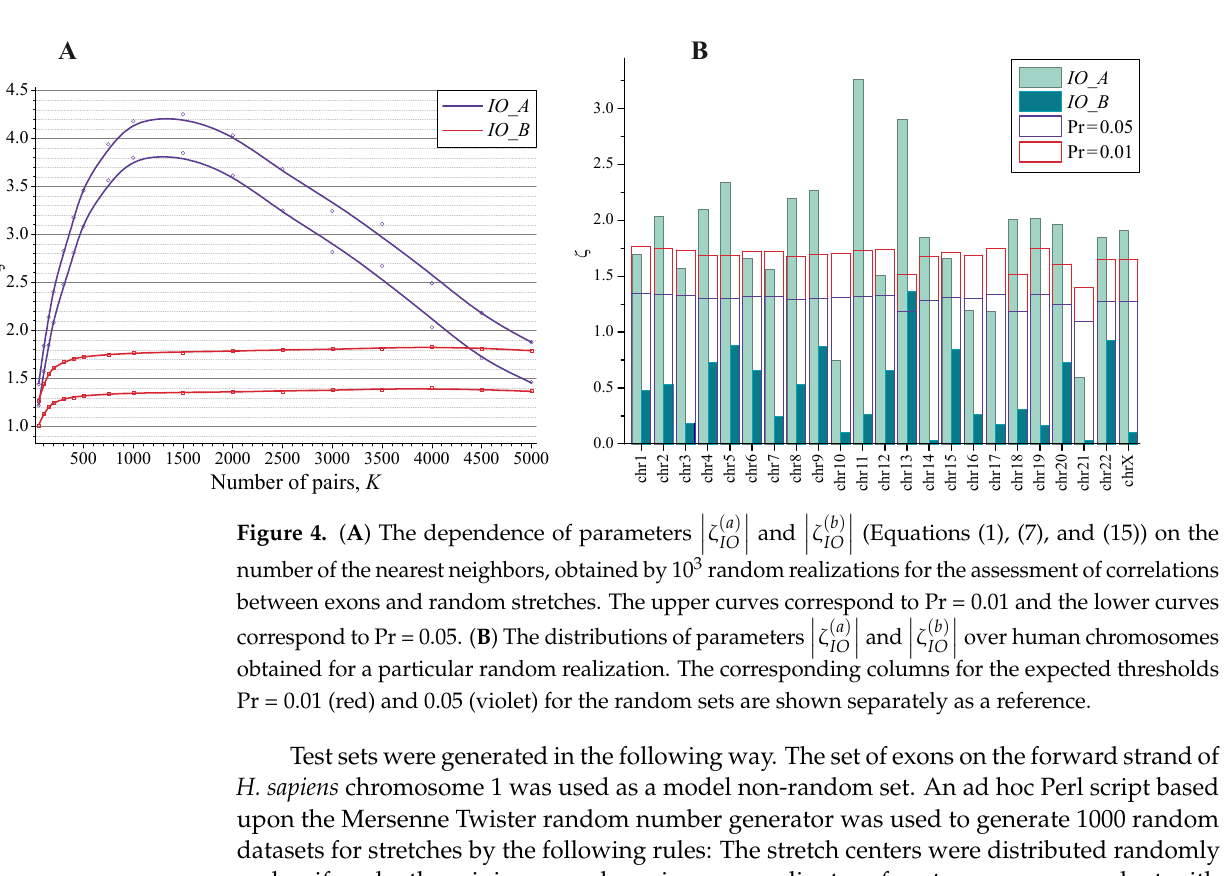
Figure 4. ( A ) The dependence of parameters number of the nearest neighbors, obtained by 10 3 random realizations for the assessment of correlations between exons and random stretches. The upper curves correspond to Pr = 0.01 and the lower curves correspond to Pr = 0.05. ( B ) The distributions of parameters obtained for a particular random realization. The corresponding columns for the expected thresholds Pr = 0.01 (red) and 0.05 (violet) for the random sets are shown separately as a